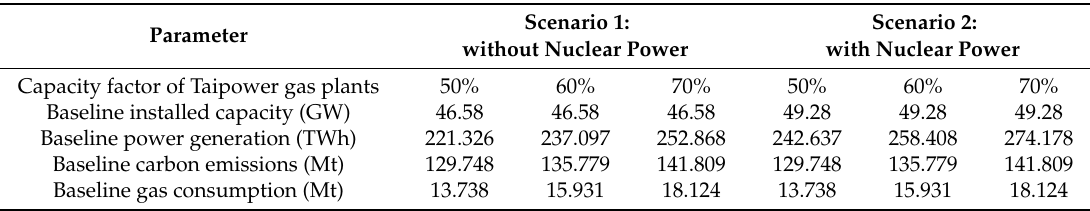
Table 6. Baseline energy mix